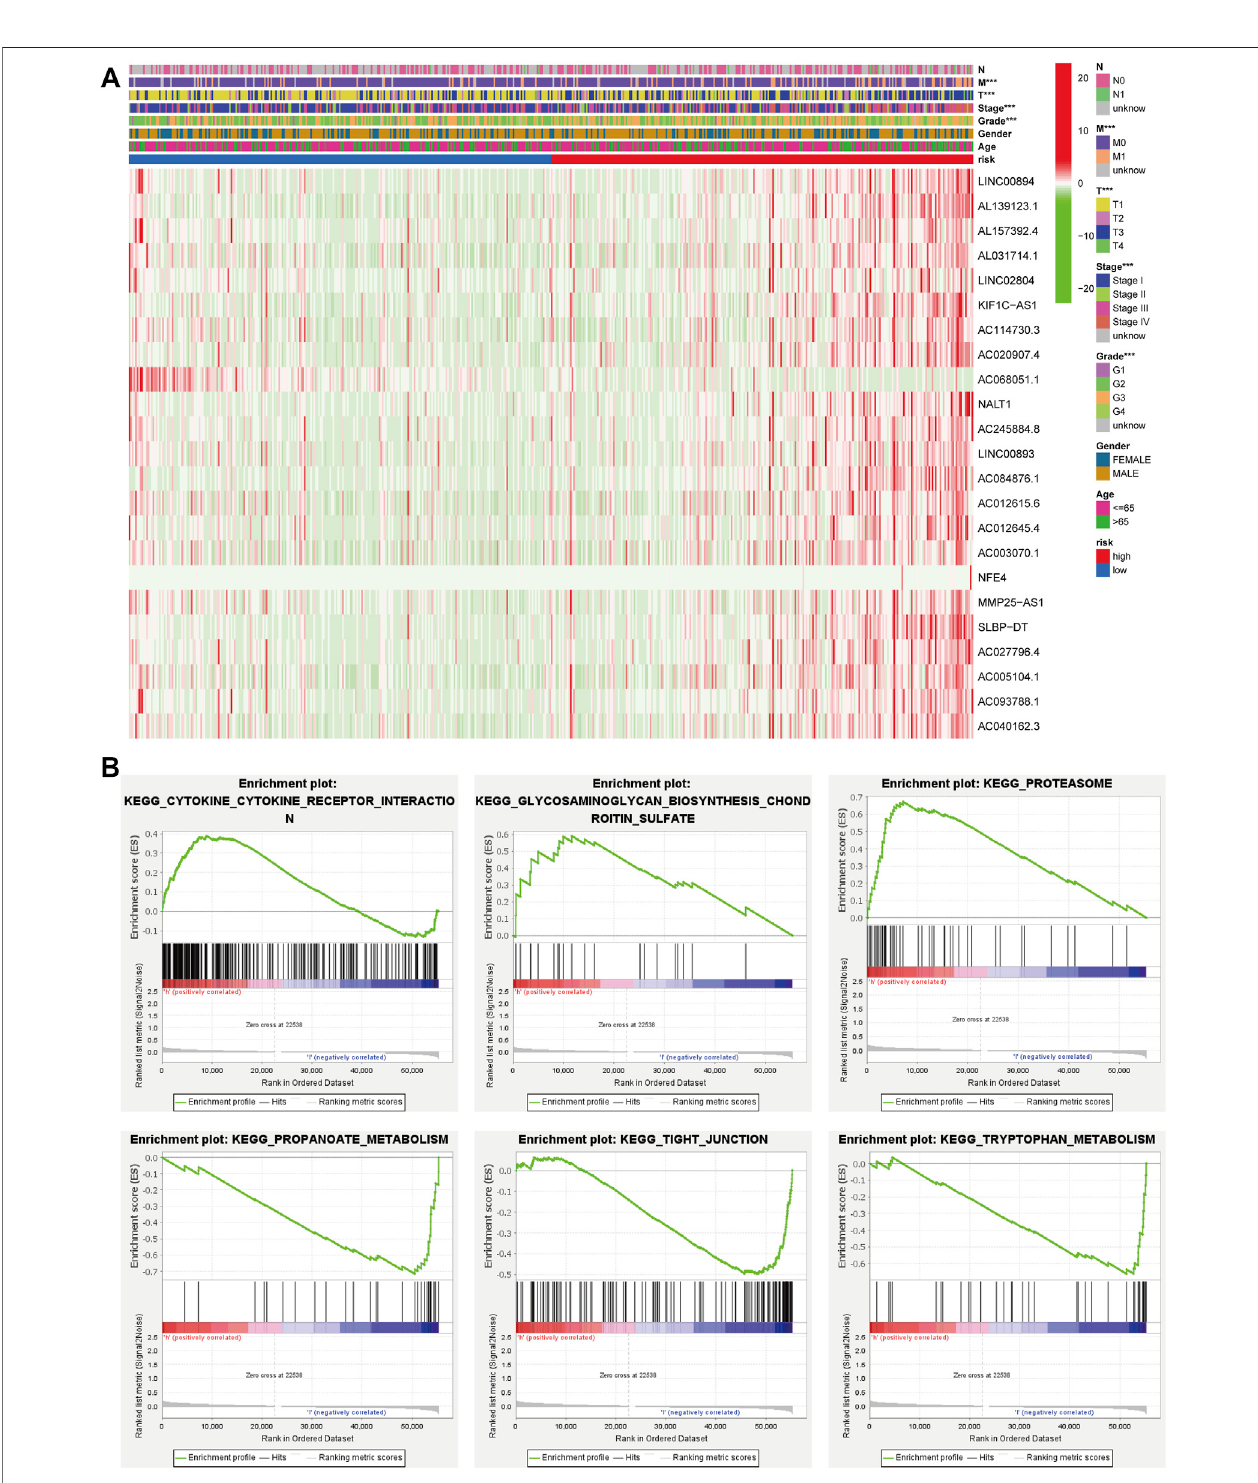
FIGURE4| GSEAandheatmapoftheclinicalrelevanceofFRLs. (A) GSEAanalyzedthepotentialdownstreamsignalingpathwaysforFRLs. (B,C) Theheatmapof the clinical relevance of FRLs.